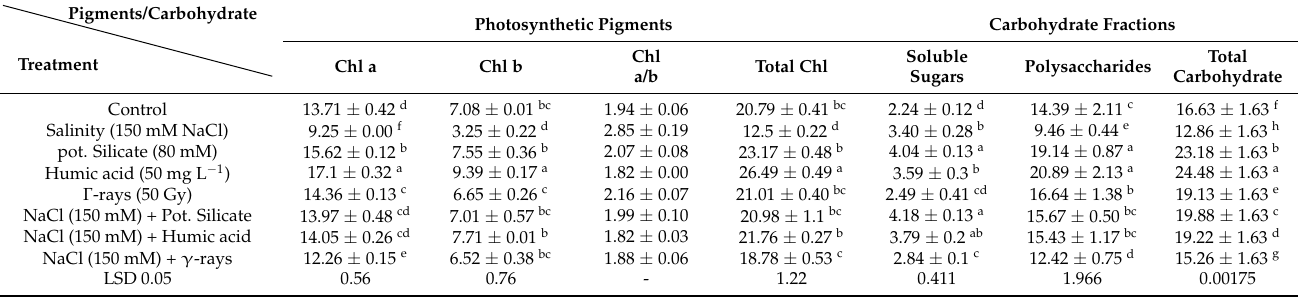
Table 6. Influence of biostimulants’ pretreatments on photosynthetic pigments ( µ g g − 1 D. wt. in coriander leaves) and carbohydrate contents (g/100 g D. wt.) at flowering stage of coriander plants under salinity stress. Control and salinized stressed coriander samples were subjected to 80 mM pot. silicate, 50 mg L − 1 HA or soaked in water after exposure by 50 Gy γ -rays. Based on Duncan’s multiple range test, the different alphabetical letters express significant variation (defined as p <